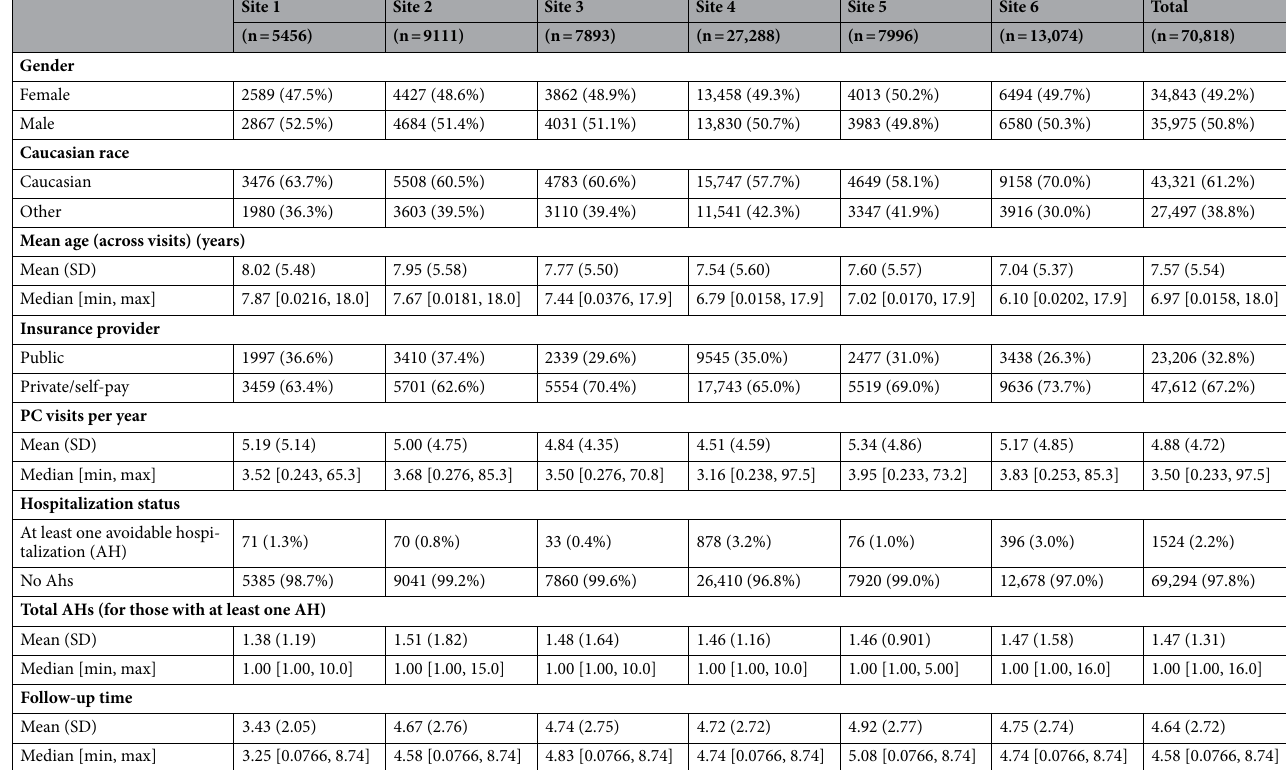
Table 2. Summary statistics describing patient population across six CHOP primary care sites.